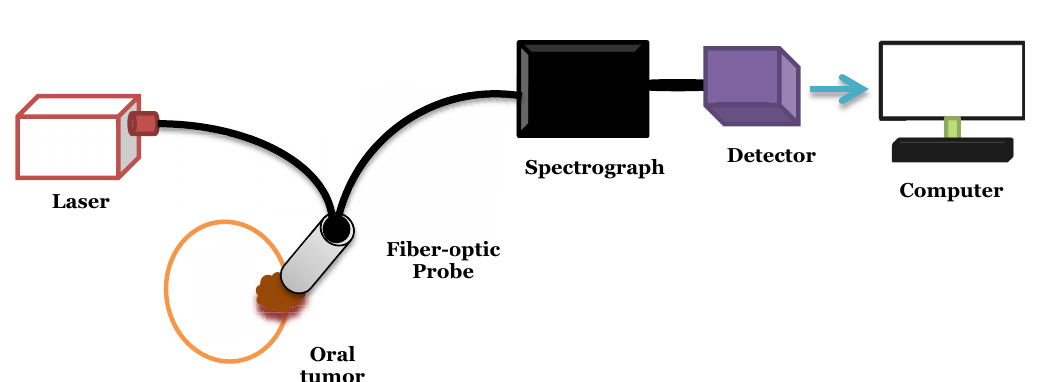
Fig. 2. Schematic representation of ¯ber-optic Raman